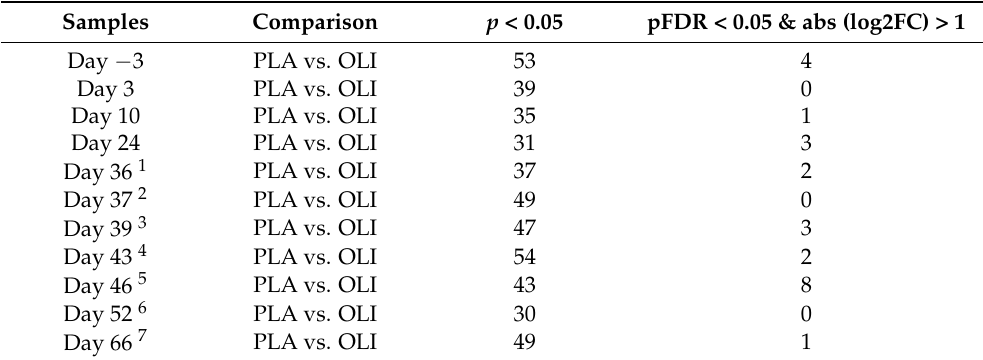
Table 2. Number of differentially abundant features in the pairwise comparisons of the two groups at different time points during the experiment.